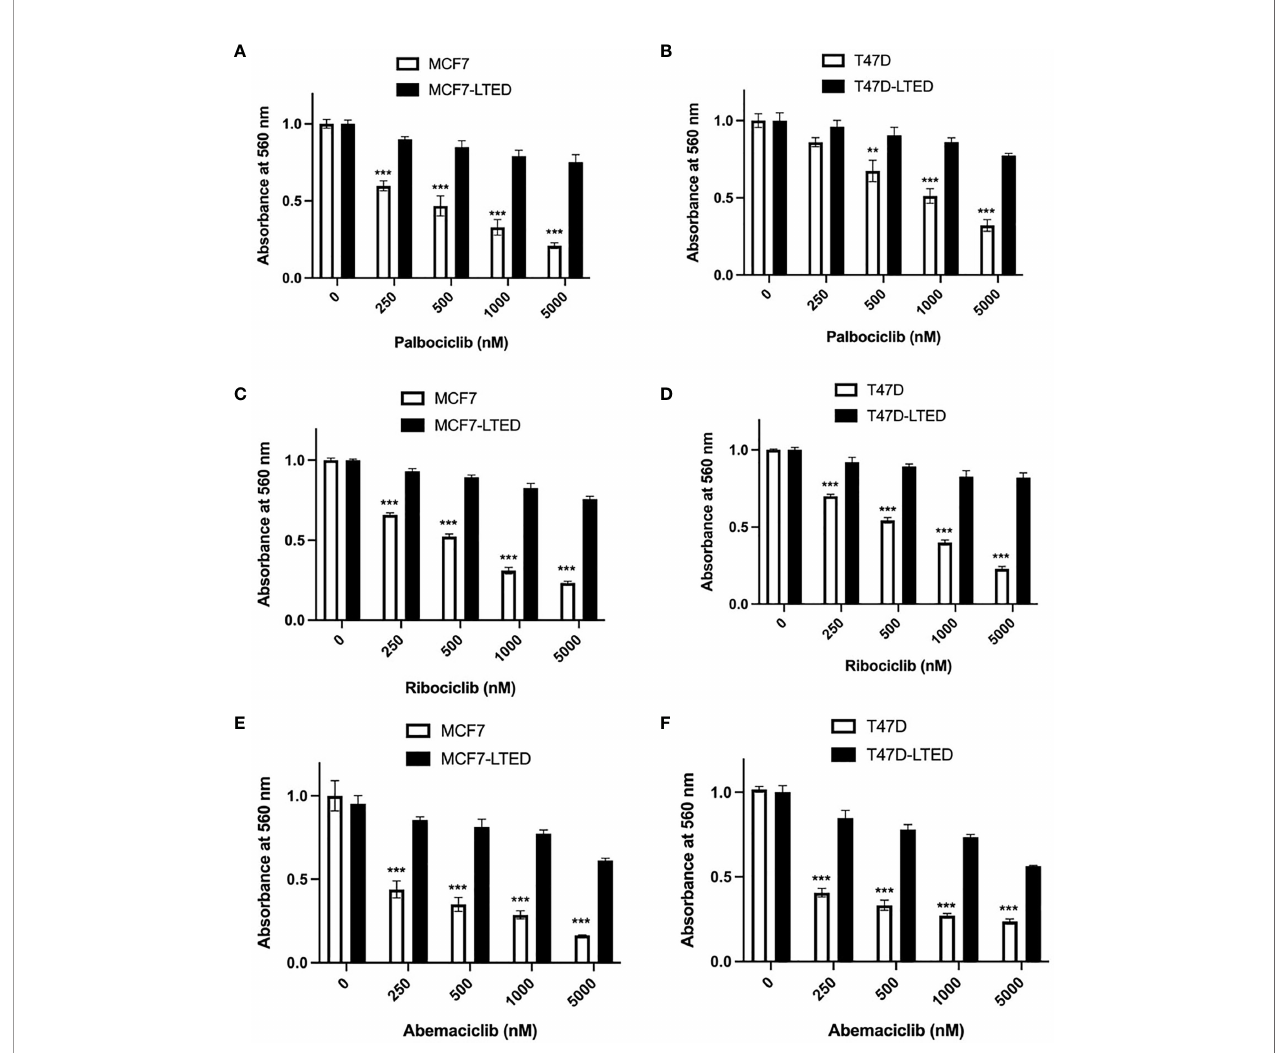
FIGURE 2 | LTED cells are resistant to CDK4/6 inhibitors. (A – F) The growth rates of parental cells (MCF7 and T47D) and their derivatives (MCF7-LTED and T47D- LTED) were measured in presence of vehicle, palbociclib, ribociclib or abemaciclib for 6 days (media was replenished at 72 h). Cell number was measured by crystal violet assays in 96-wells; absorbance was read at 560 nm. Points represent the mean±SE of relative number (normalized to 0 nM) for a single representative experiment performed in sextuplicate. **p < 0.01 and ***p < 0.001 (ANOVA) for cell number at indicated drug concentrations compared with 0 nM for indicated cell lines. Data presented here is representation of three independent experiments